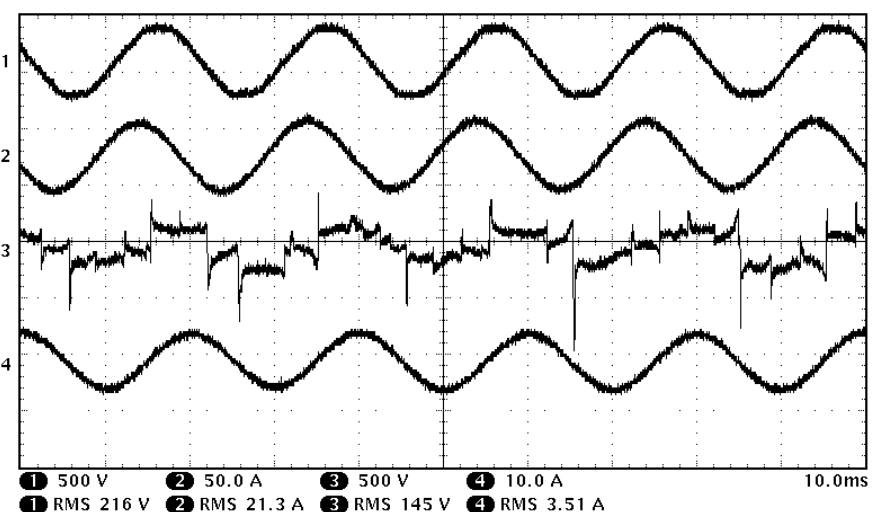
Figure 8. Current and voltage waveforms of the TPS power supply, 1 — input voltage, 2 — input current, 3 — output voltage, 4 — output current, plasma gas: argon, flow: 2.8 m 3 /h.